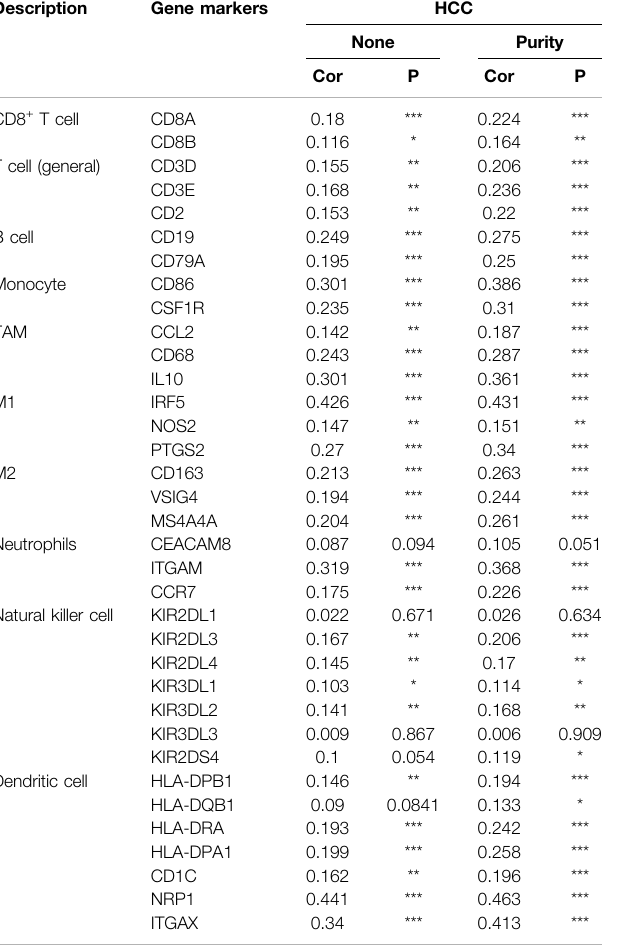
TABLE 2 | Correlation analysis between HSF2 expression and gene markers of immune cells using GEPIA.